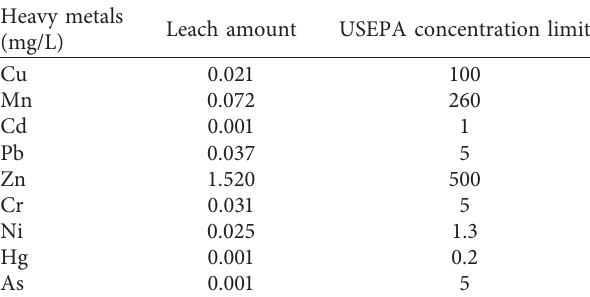
Table 5: Leach analysis